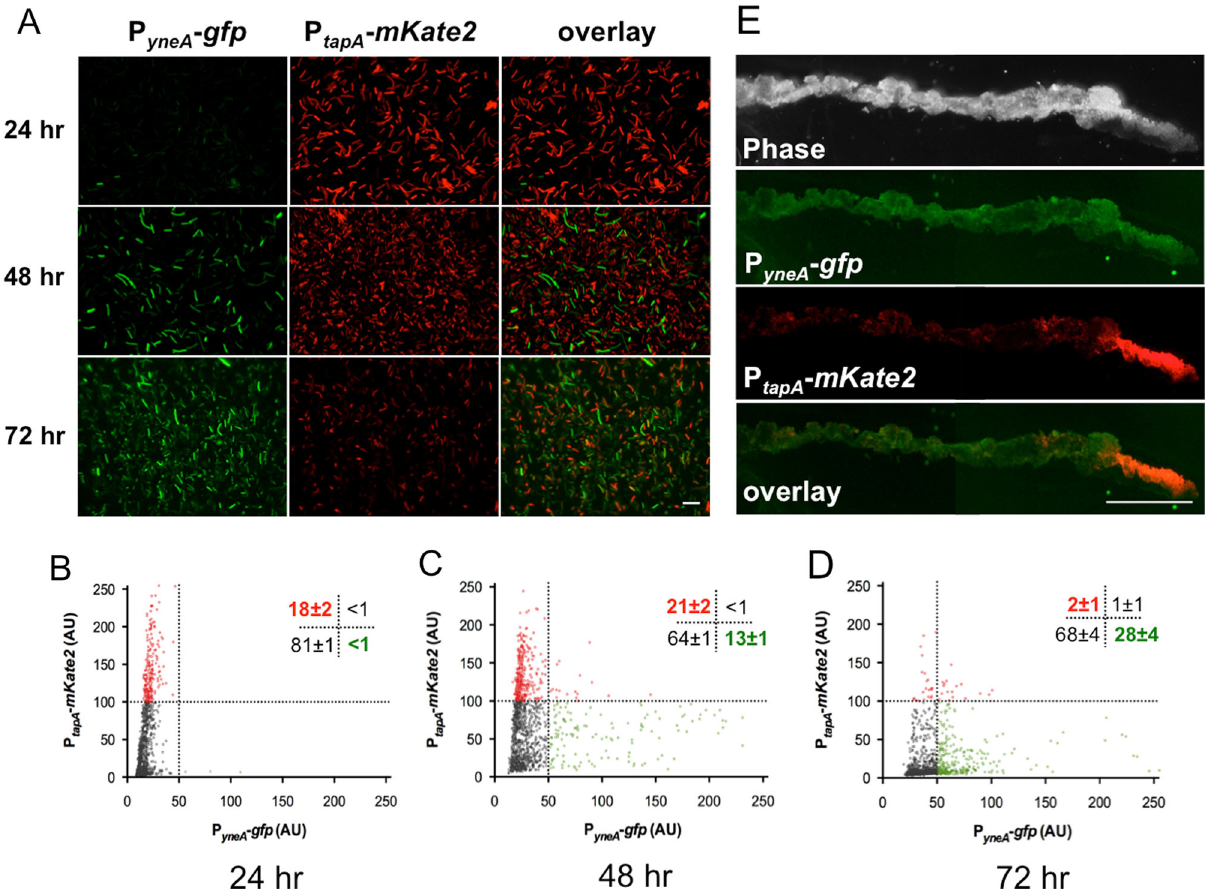
Fig. 2 DDR ON cells and matrix producers are mutually exclusive and spatially separated in the B. subtilis bio fi lm. a DDR ON cells and matrix producers are mutually exclusive cell types. Pellicle bio fi lms by the dual reporter strain (YCN040: P yneA - gfp , green , DDR reporter; P tapA - mKate2 , red , matrix reporter) were collected after 24, 48, and 72 h of incubation and examined under fl uorescent microscopy for DDR (P yneA - gfp ) and matrix gene expression (P tapA - mKate2 ). An overlay image of cells expressing the two reporters is shown. Scale bar represents 10 μ m. b – d Quanti fi cation of DDR ON and matrix producer cells. Statistic analyses of cells collected at 24, 48, and 72 h from a using MicrobeJ plugin for ImageJ. 44 Each dot represents a cell, y -axis represents red fl uorescent intensity (matrix) while x -axis represents green fl uorescent intensity (DDR). The horizontal and vertical dotted lines represent the thresholds used to de fi ne DDR ON and matrix producing cells. Provided data set represents one independent replicate. The values in the upright corner of each panel are the average percentage ratio with standard devation of cells that fell into the corresponding area in the plot, determined from three biological replicates. e DDR ON cells and matrix producers have distinct spatial localization in the bio fi lm. Thin-section fl uorescent microscopic analysis of a 48-h colony bio fi lm formed by the dual reporter strain showing spatial localization of DDR ON cells (P yneA - gfp ) and matrix producers (P tapA - mKate2 ). Scale bar represents 1